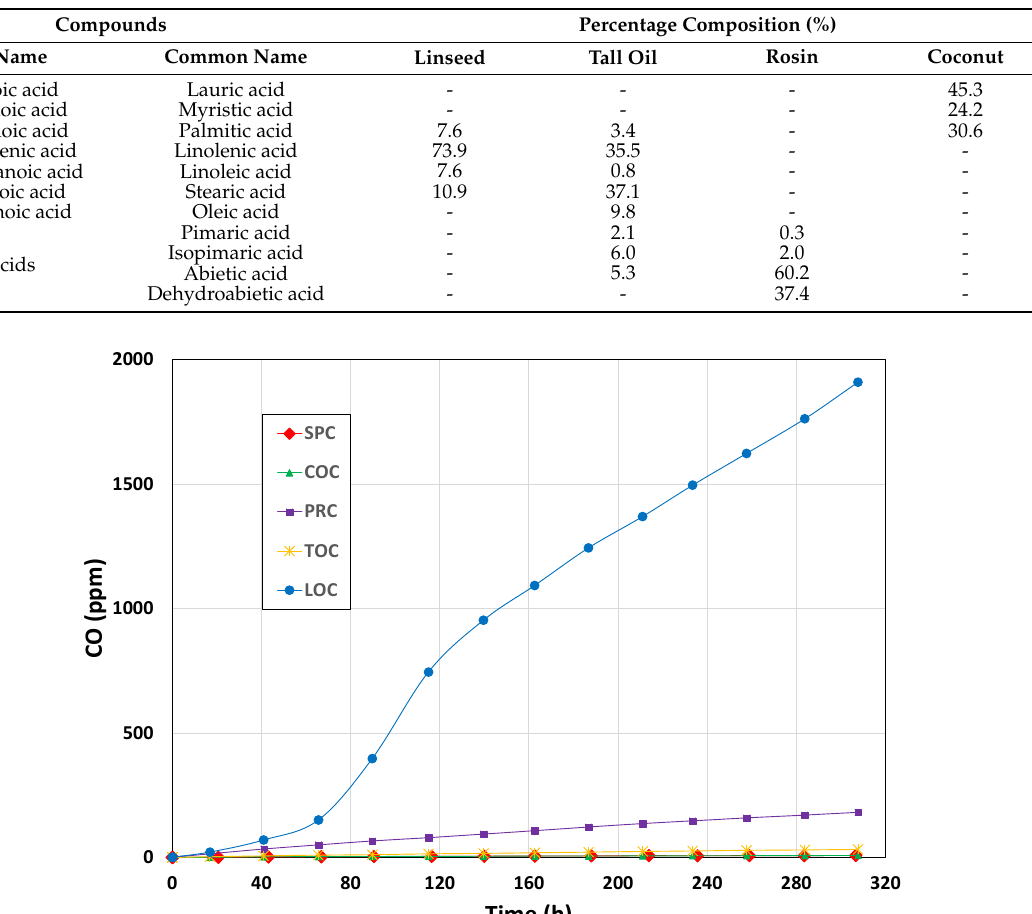
Figure 1. Cumulative carbon monoxide (CO) mean concentrations in the containers over the thirteen days test period for each of the five materials. Pellets made from: SPC—100% synthetic pure cellu- lose, COC—cellulose plus 10% coconut oil, PRC—cellulose plus 10% pine rosin, LOC—cellulose plus 10% linseed oil, TOC—cellulose plus 10% tall oil.